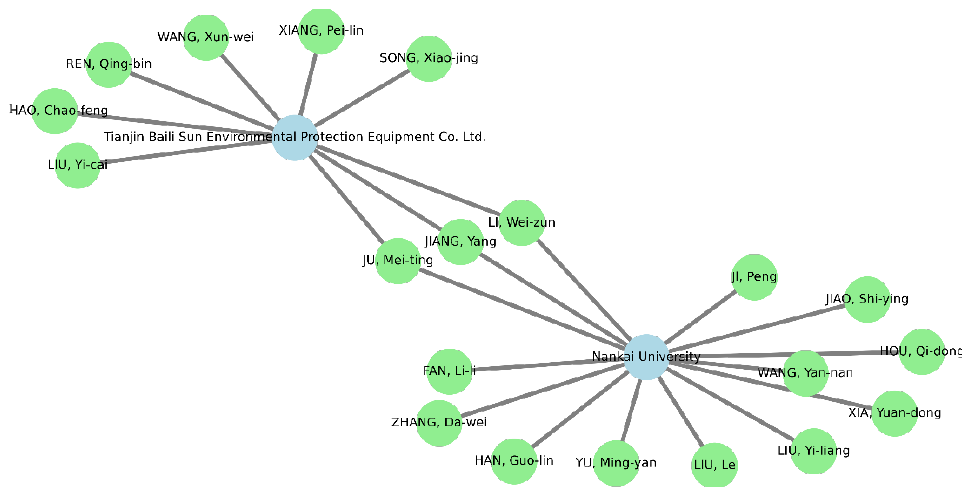
Figure 12. Network diagram of the assignees and inventors.